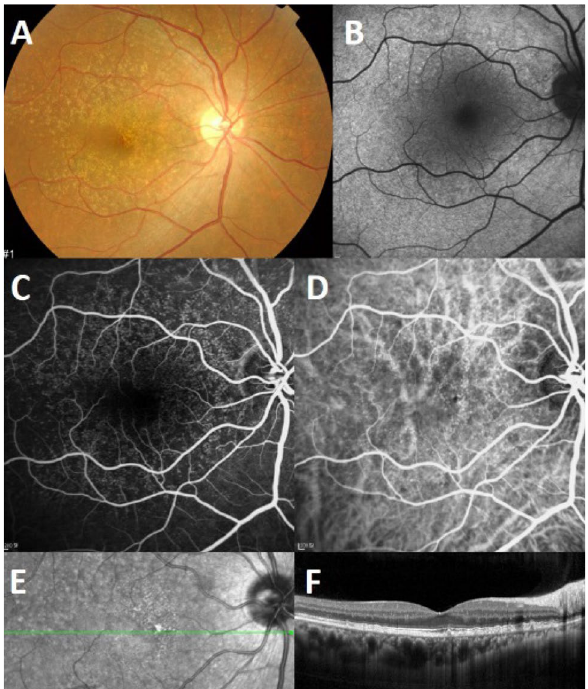
Figure 1. Multimodal imaging of cuticular drusen. CFP ( A ) shows multiple scattered pale or yellow spots. A hypoautofluorescent center with a mild hyperautofluorescent margin was observed on FAF image ( B ). “Stars- in-the-sky” hyperfluorescent lesions are observed in the early phase of FA ( C ) and ICGA ( D ). A combination of a hyporeflective center and hyperreflectivity is seen on the NIR image ( E ). A “sawtooth pattern” of small and confluent sub-RPE deposits is observed in OCT image ( F ). CFP color fungus photography, FA fluorescein angiography, FAF fundus autofluorescence, ICGA indocyanine green angiography, NIR near-infrared reflectance, OCT optical coherence tomography, RPE retinal pigment